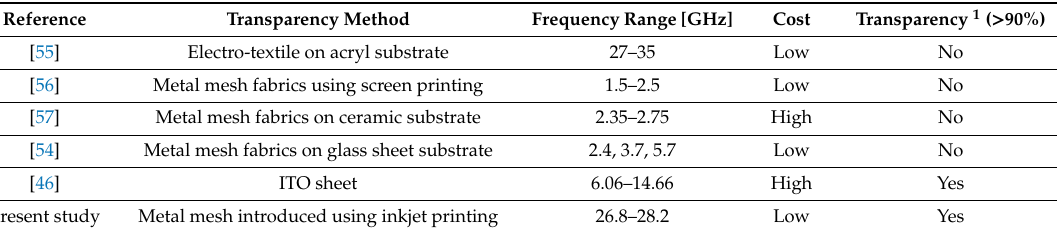
Figure 10. ( a ) Simulated and ( b ) measured reflection coefficients plotted against the frequency for different polarizations. Table 2. Comparison of the proposed optically transparent metamaterial absorber with previously reported metamaterial absorbers.